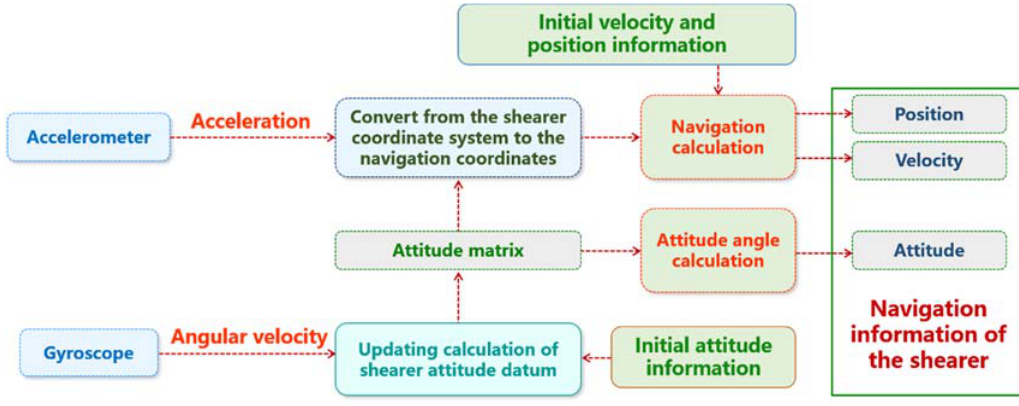
Figure 4. Principle of the shearer positioning system based on SINS.